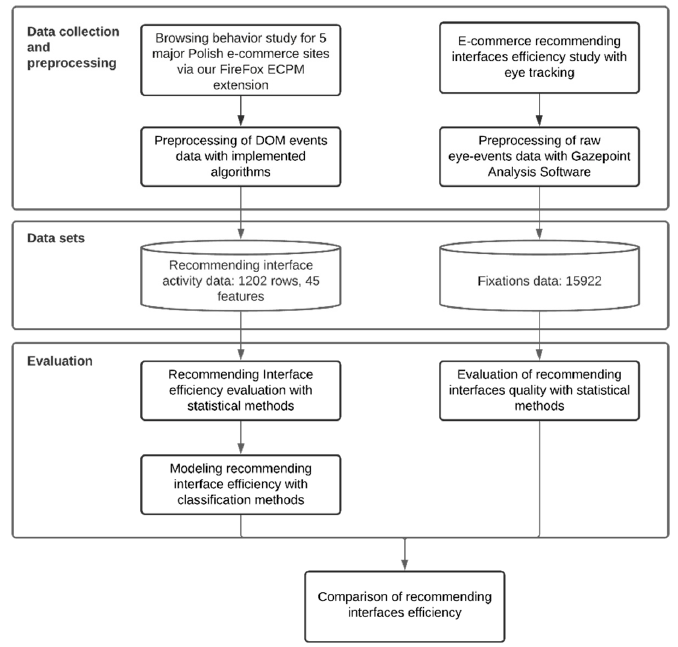
Figure 2. Research experiment architecture.